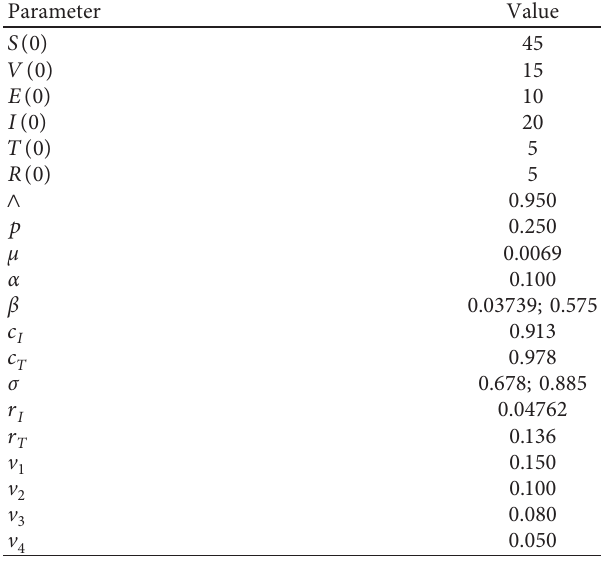
Table 2: Parameter values for the model with constant